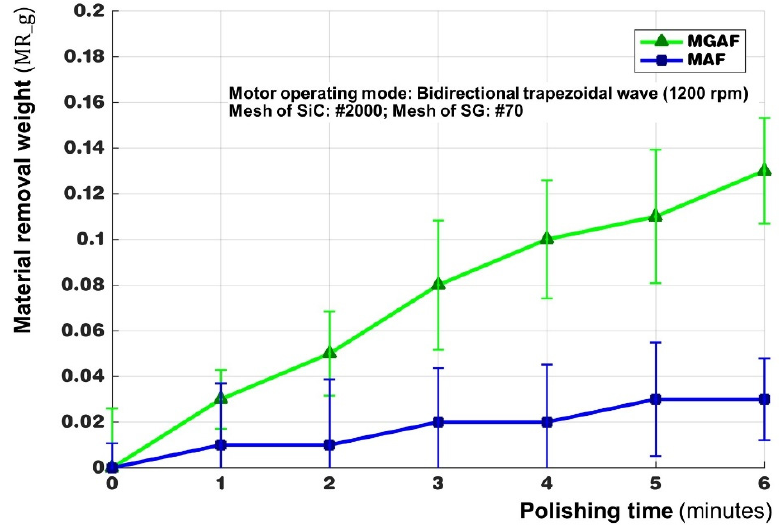
Figure 3. Comparison chart of average material weight and polishing time of MGAF and MAF.